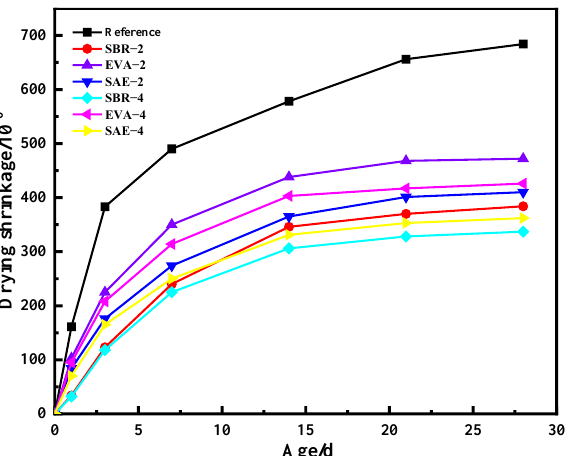
Figure 3. Effect of polymer latex content and type on drying shrinkage of mortar samples.